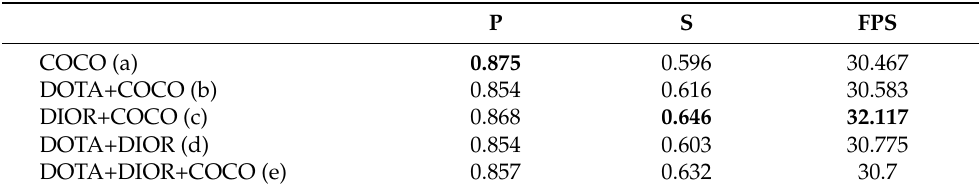
Table 3. The comparison results of different training schemes for the proposed ID-DSN. P S